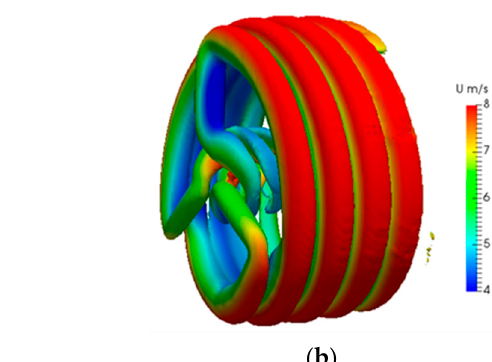
The blade deflection is abbreviated and described in Figure 21. The deformation is too small to be